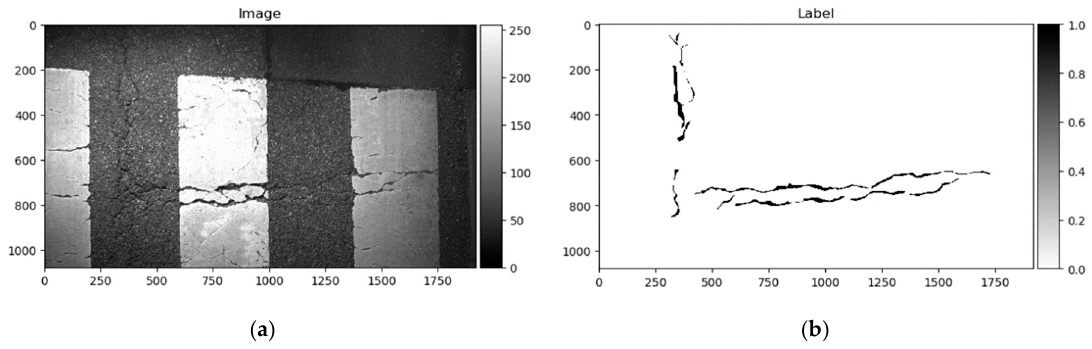
Figure 10. German Asphalt Pavement Distress (GAPs) data sample: ( a ) Image; ( b ) ground truth.